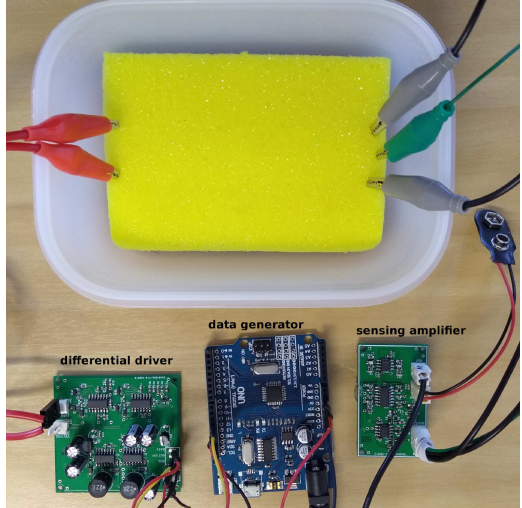
Figure 4. Full experimental setup: boards, workload generator, and phantom.